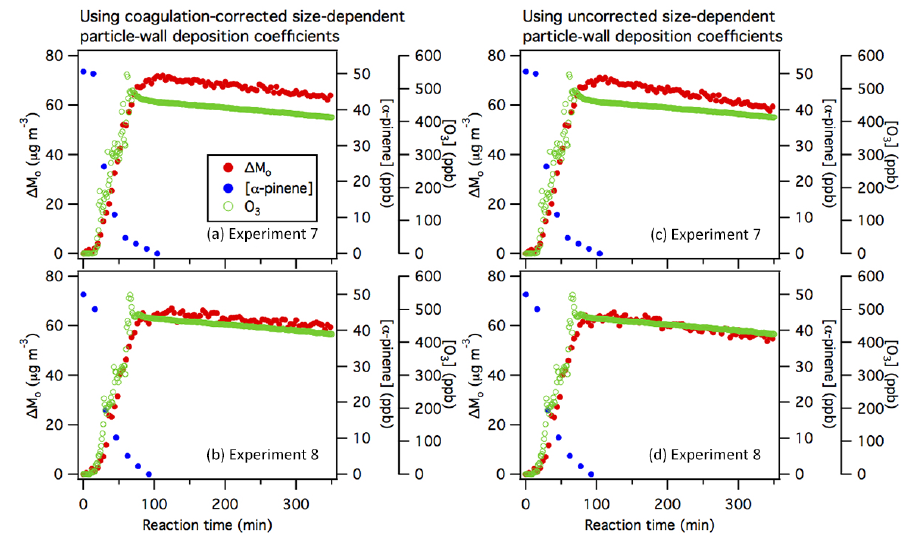
Figure 2. Reaction profiles of the low-SA α -pinene ozonolysis experiments. Panels (a) and (b) show SOA mass concentrations ( (cid:49)M o ) obtained using the coagulation-corrected size-dependent particle-wall deposition coefficients from the low-SA seed-only experiments, while panels (c) and (d) show SOA mass concentrations ( (cid:49)M o ) obtained using the uncorrected size-dependent particle-wall deposition coefficients from the low-SA seed-only experiments. Refer to Table 1 for information on the AS solution(s) used to generate the seed aerosol and the initial seed aerosol surface area concentrations in these